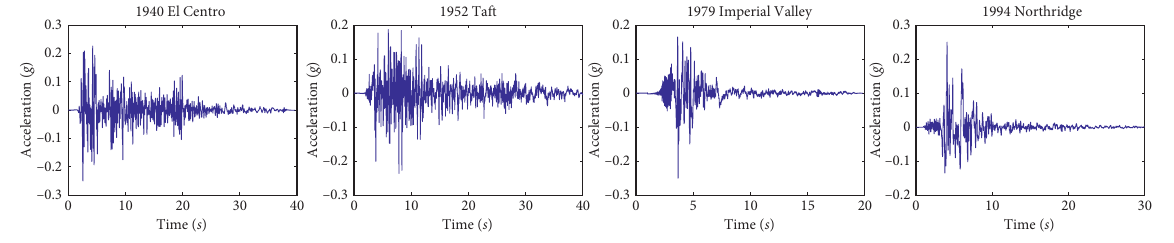
Figure 8: Ground motions. Table 2: X -direction mode of structure/(Hz).